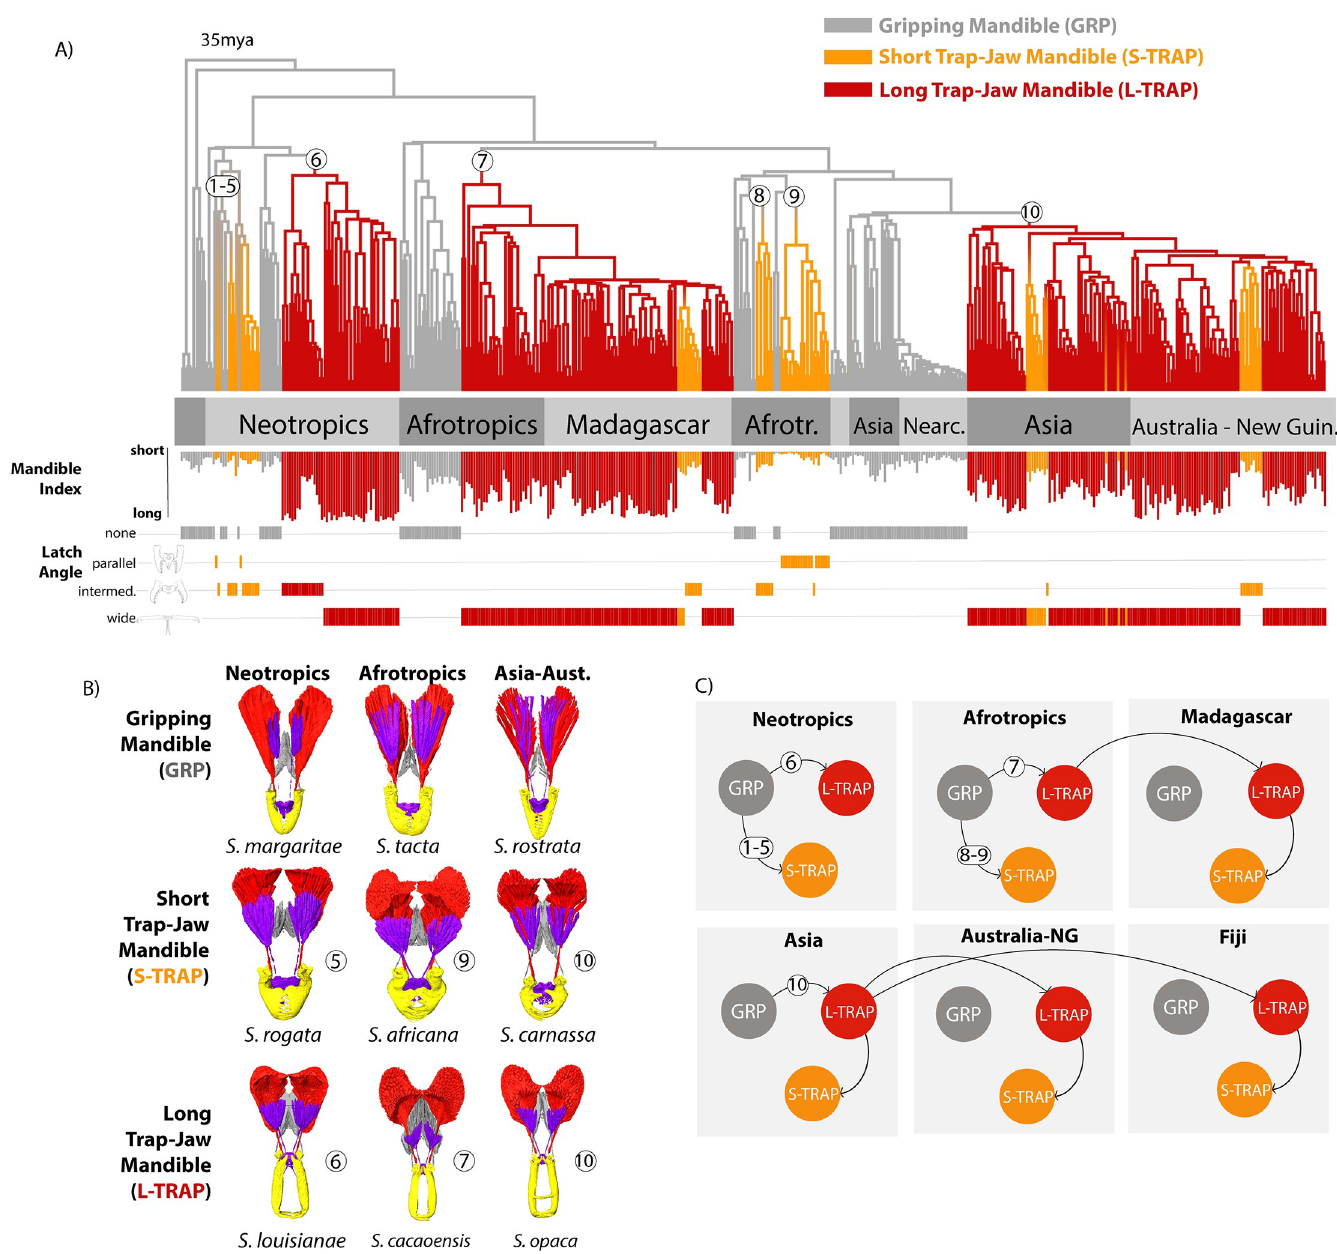
Fig 3. Mandible power-amplification mechanisms and associated ecomorphological diversity have evolved repeatedly from gripping ancestors in Strumigenys . (A) The dated maximum likelihood phylogeny of 470 Strumigenys species, annotated with estimated locations of the evolutionary transitions to power amplification (white circles, with numbers indexing the different events, not the number of transitions on each branch), and ancestral state estimations of 3 mandible morphs inferred through stochastic character mapping. Tips are annotated with mandible index (mandible length relative to head length) and latch angle (how wide the mandibles open when they reach the latch position). See S3–S5Figs for trees with detailed annotations and S2,S3 Figs for ancestral state reconstructions with different model assumptions. (B) Comparison of mandible morphs across the world based on segmented X-ray micro-CT imagery, annotated by the LaMSA evolution event (white circle, corresponding to tree). (C) Pathways to ecomorphological diversity through evolution and dispersal among regions inferred with ancestral state estimation (also see S8